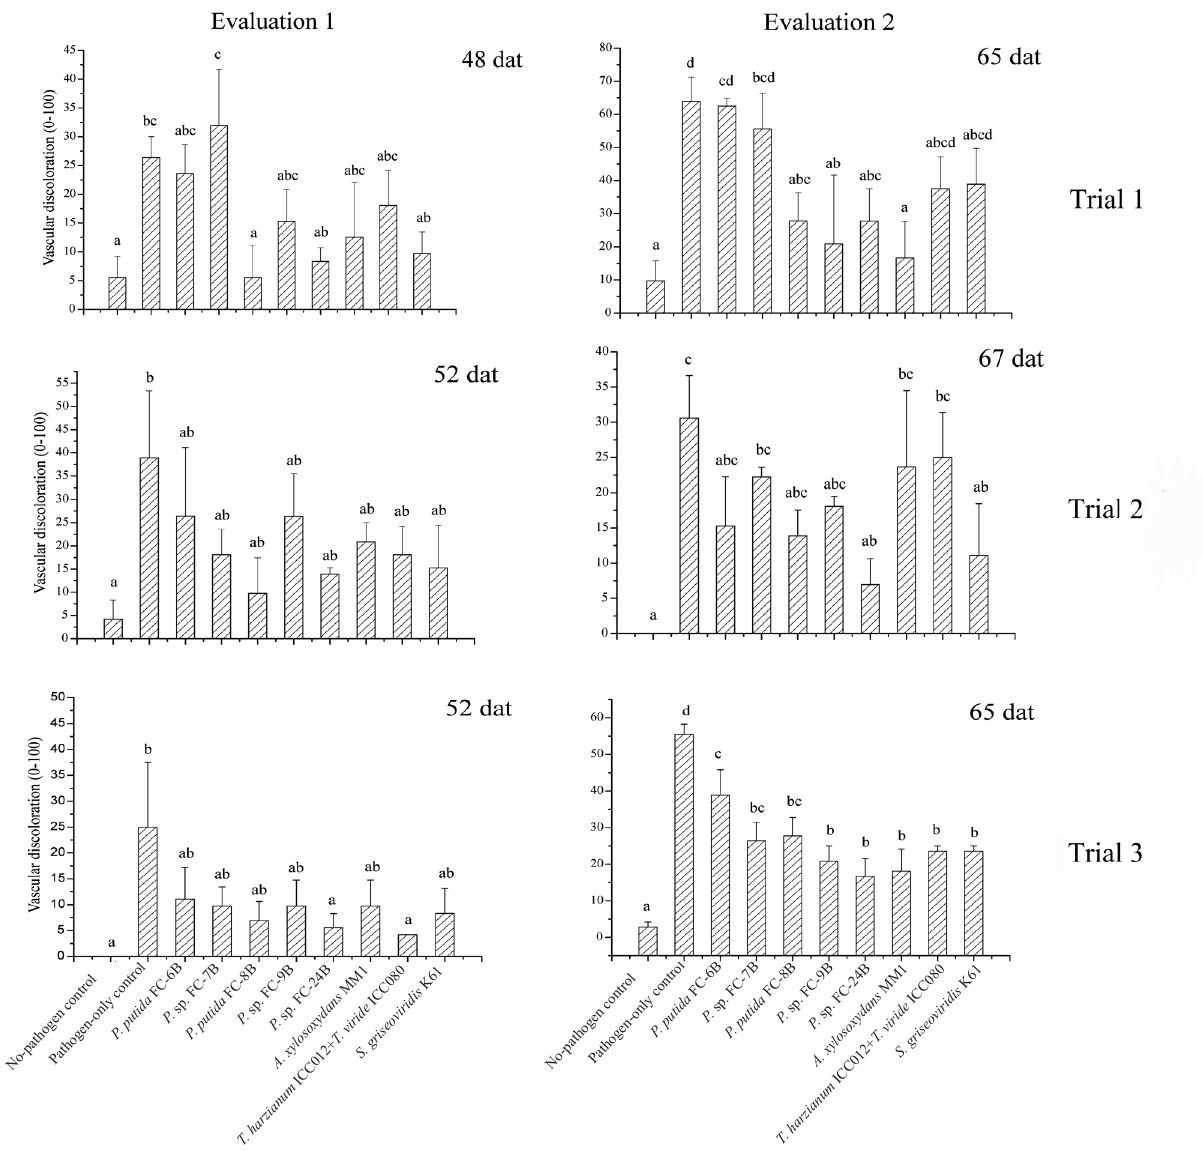
Figure 1. Biocontrol effects of various agents against Fusarium oxysporum f. sp . radicis-lycopersici on tomato in three glasshouse trials evaluated at different days after transplanting (dat), expressed as percent of vascular discoloration (VD). Vertical bars represent the standard error of three replicates from the mean at each date. Means designated by the same letter are not significantly different ( P <0.05) according to Duncan’s